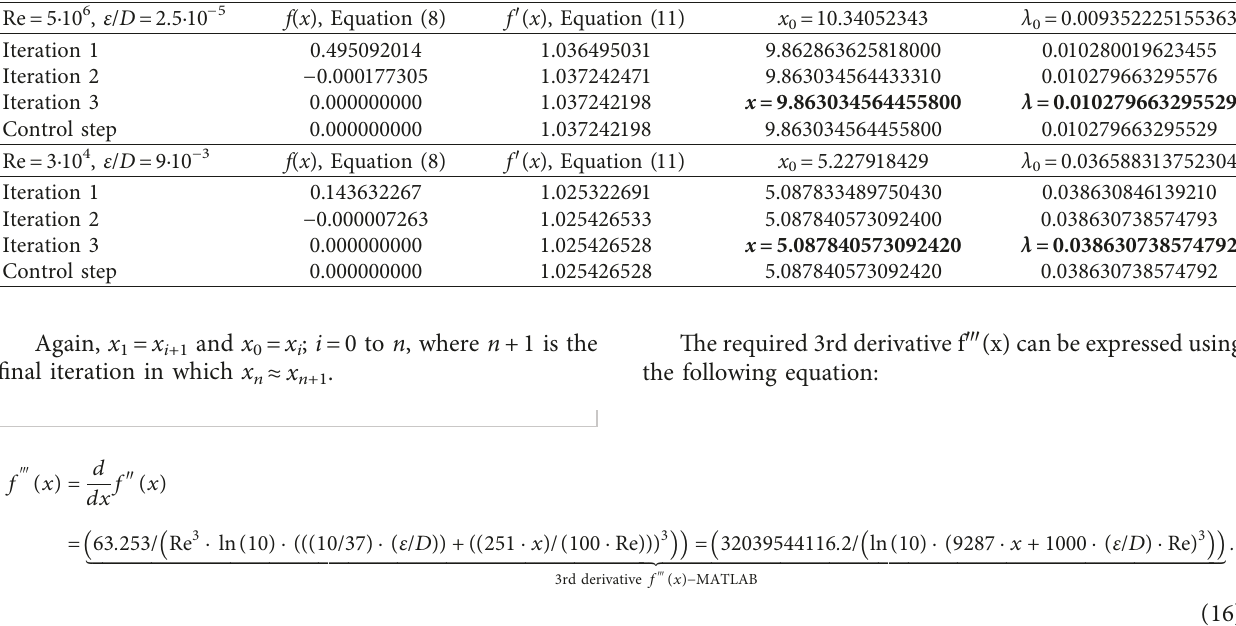
0 depends on input parameters: Equation (2), indirect calculation of λ